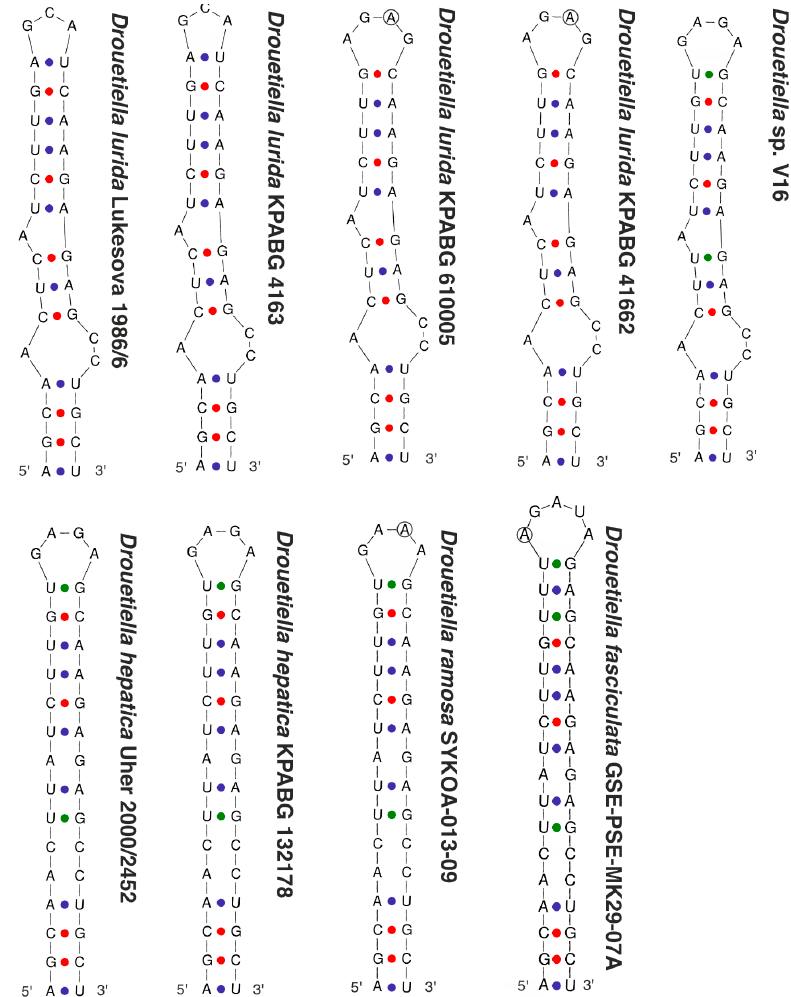
Figure 8. The secondary structure of the Box-B helices of the 16S-23S ITS rRNA region of the Drouetiella strains. Circles indicate differences.